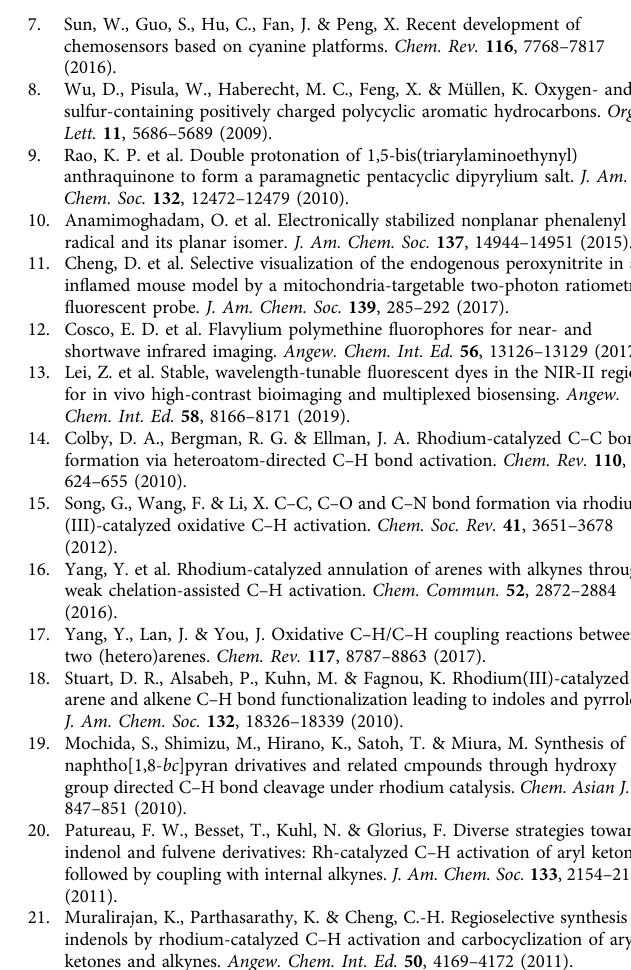
Fig. 8 Absorption and emission spectra of the BFFs in CH 2 Cl 2 at 40.0 μ M. a The absorption spectra of 3aa , 3ba , 3ca , 3da , and 3ea . b The absorption spectra of 3fa , 3ga , 3ab , 3ac and 3ad . c The emission spectra of all